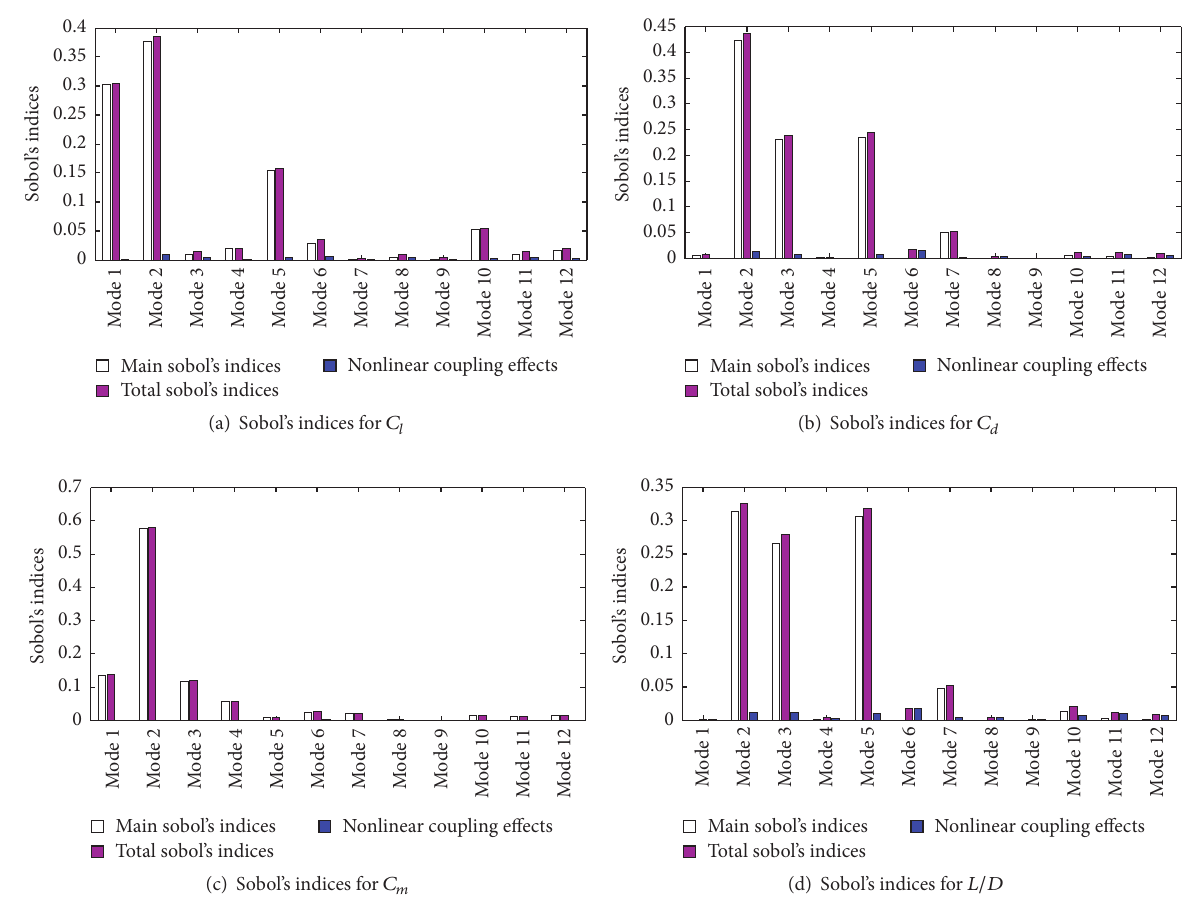
Figure 16: The results of Sobol’s analysis of aerodynamics ((a) Sobol’s indices for 𝐶 𝑙 ; (b) Sobol’s indices for 𝐶 𝑑 ; (c) Sobol’s indices for 𝐶 𝑚 ; (d) Sobol’s indices for 𝐿/𝐷